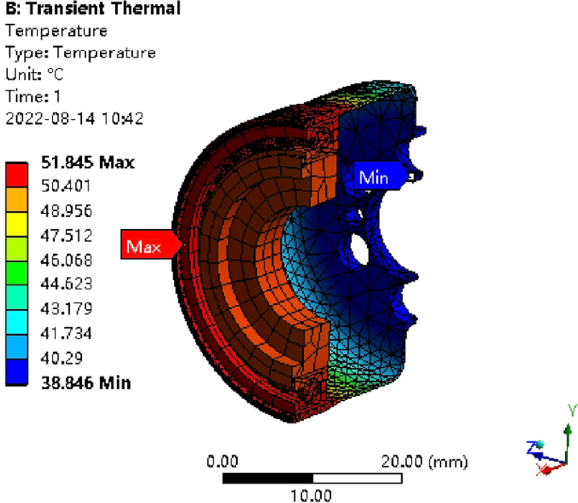
Figure 9: Temperature fi eld of HD in thermal steady state.